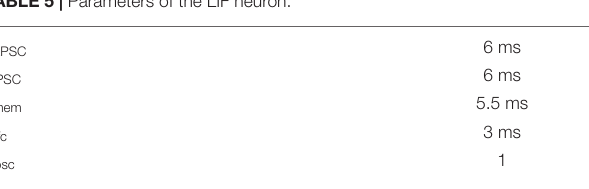
TABLE 5 | Parameters of the LIF